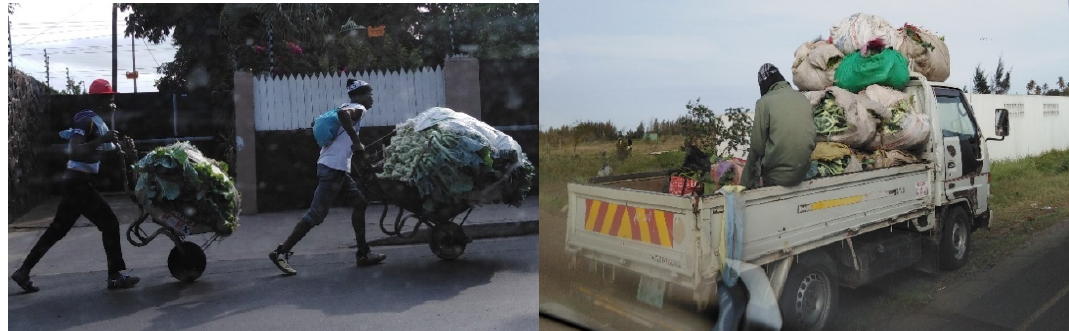
Figure 4. Transportation of products to markets, before sale, in wheelbarrows and propylene raffia bags.